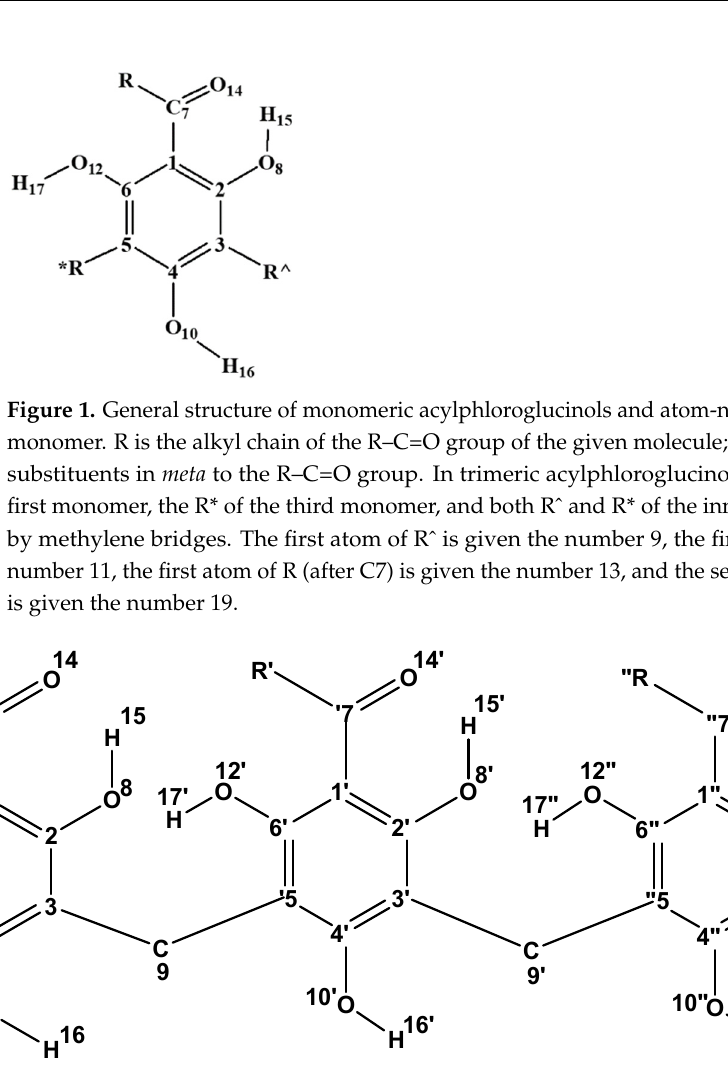
Figure 2. General structure of trimeric acylphloroglucinols and atom numbering utilised in this work. The same atom numbering is utilised for corresponding atoms in each monomer and reflects the numbering shown in Figure 1. R is the alkyl chain of the R − C=O group of the given molecule; R^ and R* denote possible substituents in meta to the R − C=O group. The numbers of the atoms of the second monomer (inner monomer) are primed and the numbers of those of the third monomer are double-primed.